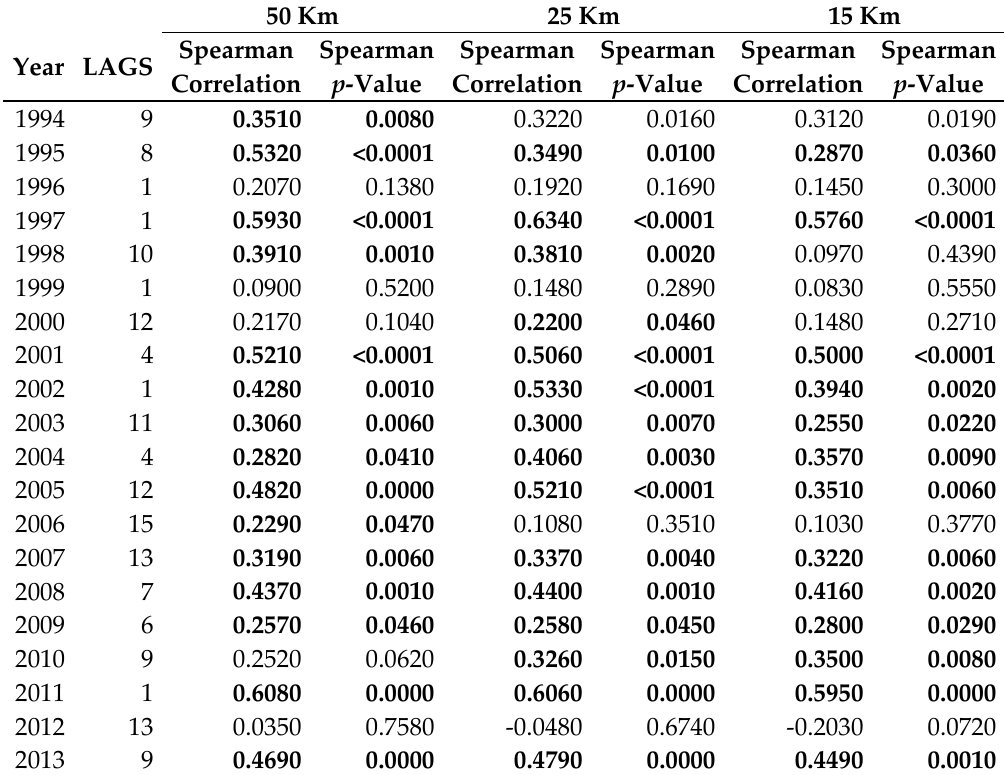
Table 1. Statistical Spearman test results in the three training areas (significant correlations in